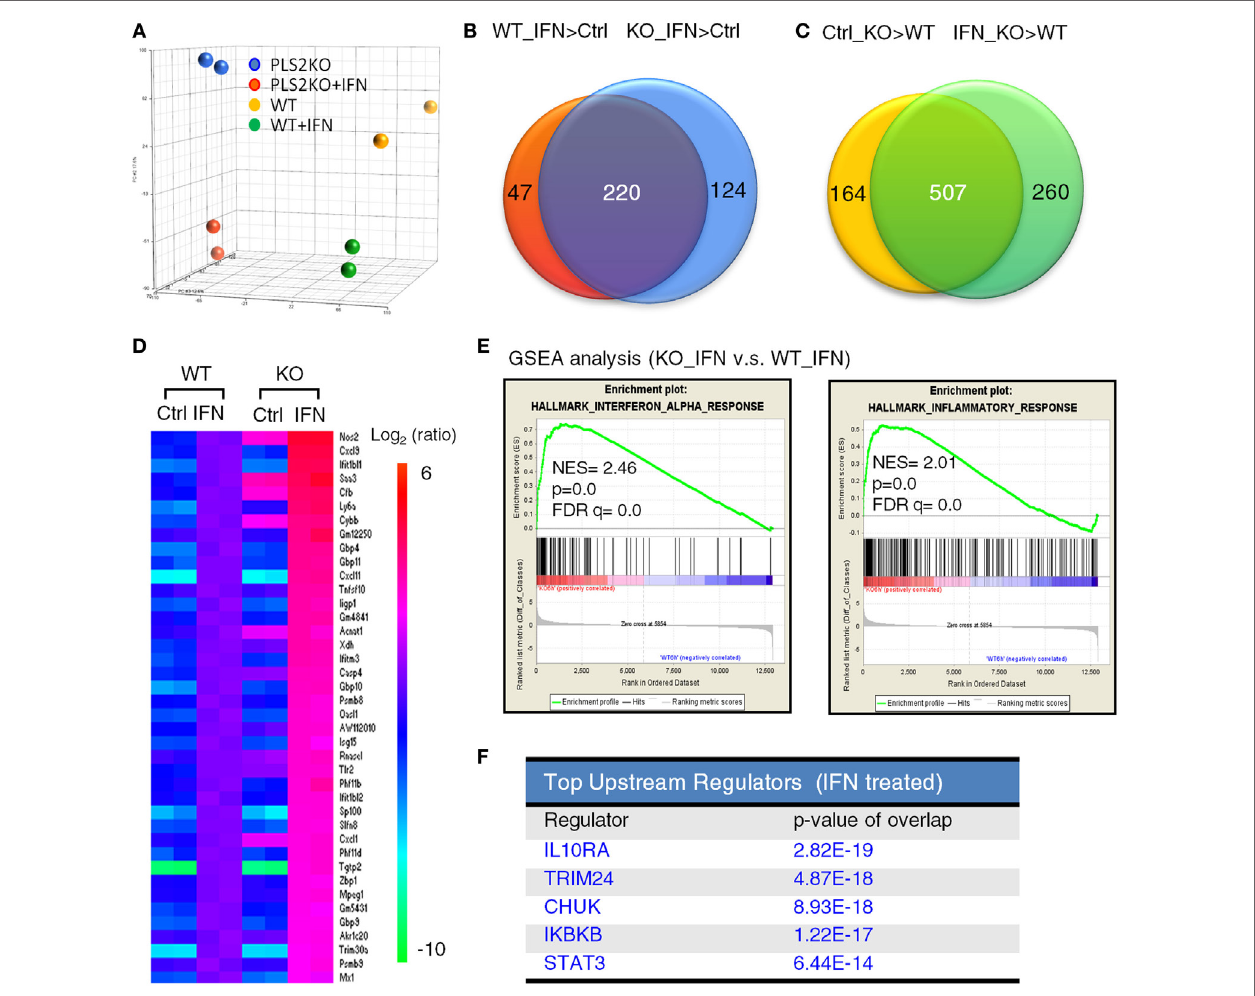
FigUre 3 | Phospholipid scramblase 2 (PLSCR2) deficiency enhances type I interferon (IFN-I)-induced antiviral and inflammatory gene signature. (a) Principal component analysis based on the gene expression profiles of WT and PLS2KO ML1 cells with or without IFN- α 4 treatment for 6 h. (B,c) Venn diagram of shared upregulated genes (at least 2.0-fold changes and p < 0.05) in panel (B) WT (red) and PLS2KO (blue) cells following IFN- α 4 6 h treatment vs. no treatment (ctrl), or in panel (c) no treatment (yellow) and IFN- α 4 6 h treatment (green) in PLS2KO and WT cells. (D) Heatmap analysis of the upregulated IFN-stimulated genes (ISGs) in WT and PLS2KO cells. (e) Gene set enrichment analysis (GSEA) for IFN- α and inflammatory response genes. Abbreviations: NES, normalized enrichment score; FDR, false discovery rate. (F) Top upstream regulators analysis by ingenuity pathway analysis for IFN-I-treated WT vs. PLS2KO ML1